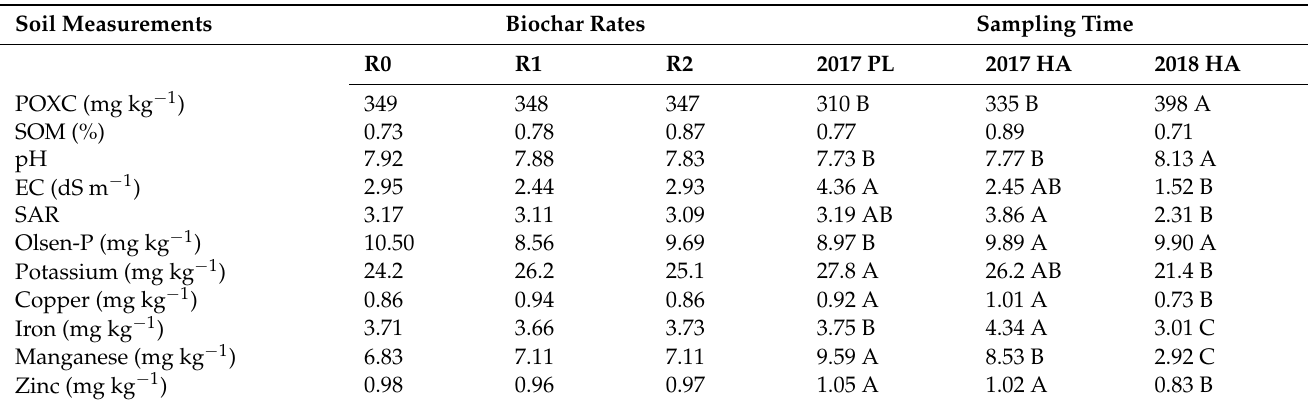
Table 4. Means for soil properties from pinto bean plots averaged across biochar treatments and sampling times: PL-before planting, HA-after harvest.